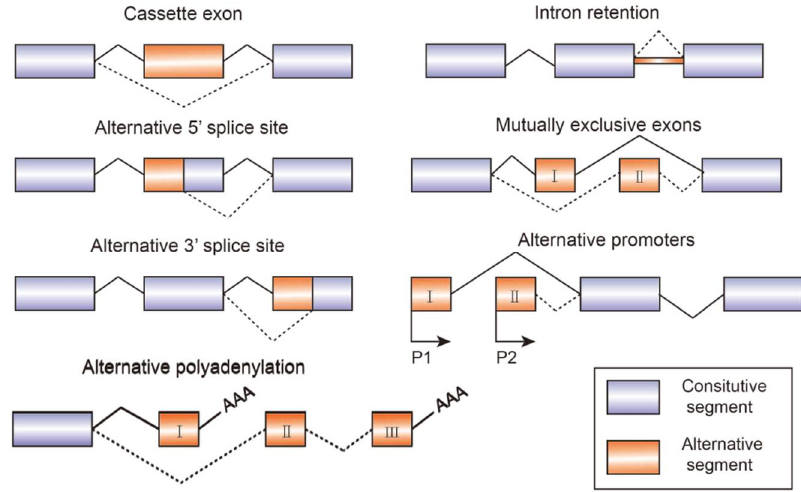
Figure 1. Schematic figure representing seven modes of alternative splicing of pre-mRNA: cassette exon, intron retention, alternative 5′ splice site, mutually exclusive exons, alternative 3′ splice site, alternative promoters, and alternative polyadenylation. Alternative splicing sites are connected by dashed lines. Boxes represent exons and lines represent introns.